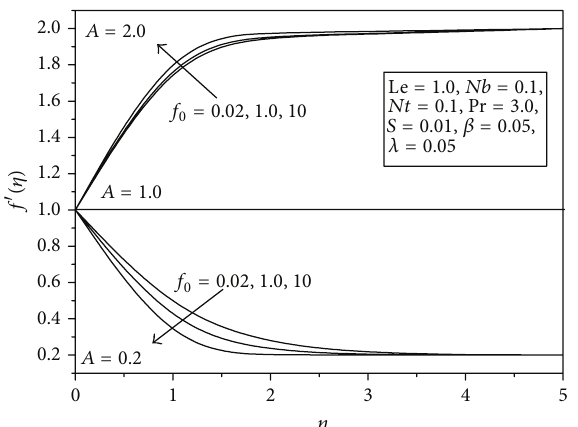
Figure 7: Velocity profile for different values of 𝑓 0